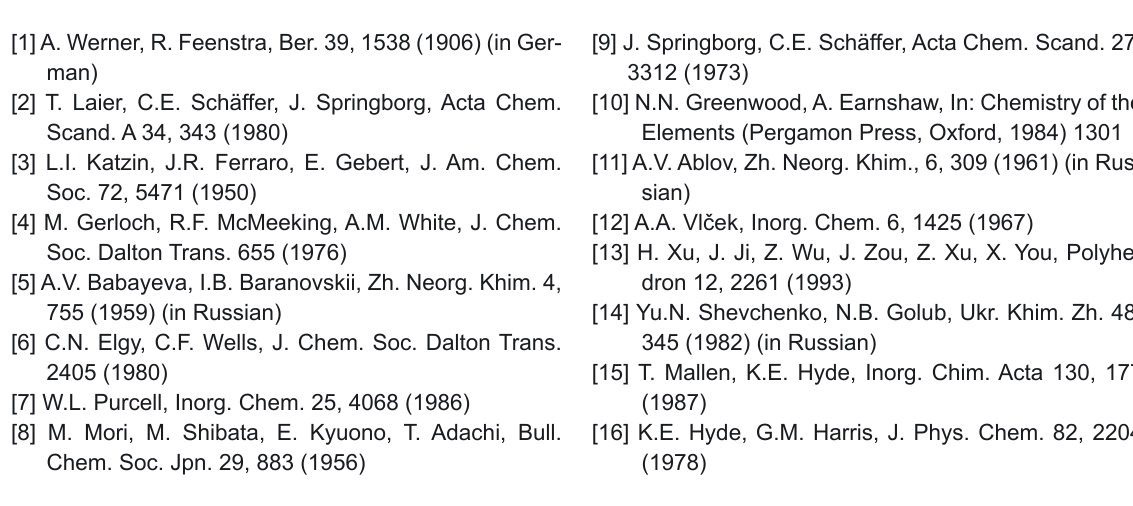
tion, occurring spontaneously in CHCl